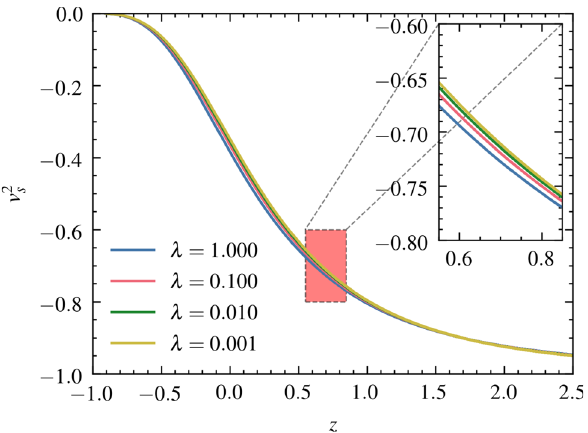
Fig. 10 Sound speed squared ( v 2 s ) as a function of redshift ( z ) for different values of λ (with (cid:12) m 0 = 0 . 315 and H 0 = 67 . 4 km/s/Mpc